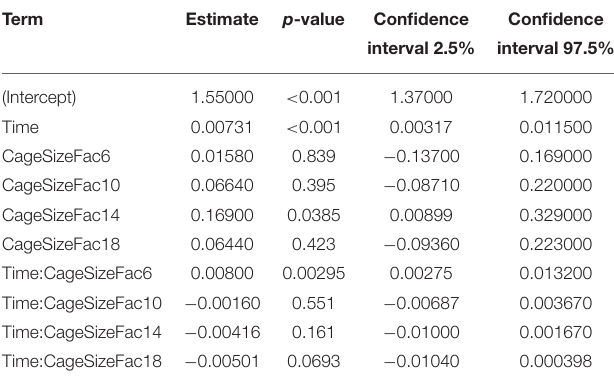
TABLE 8 | Table of coefficients for the fixed effects and interactions for the PGEM mixed effect model. Term Estimate p -value Confidence